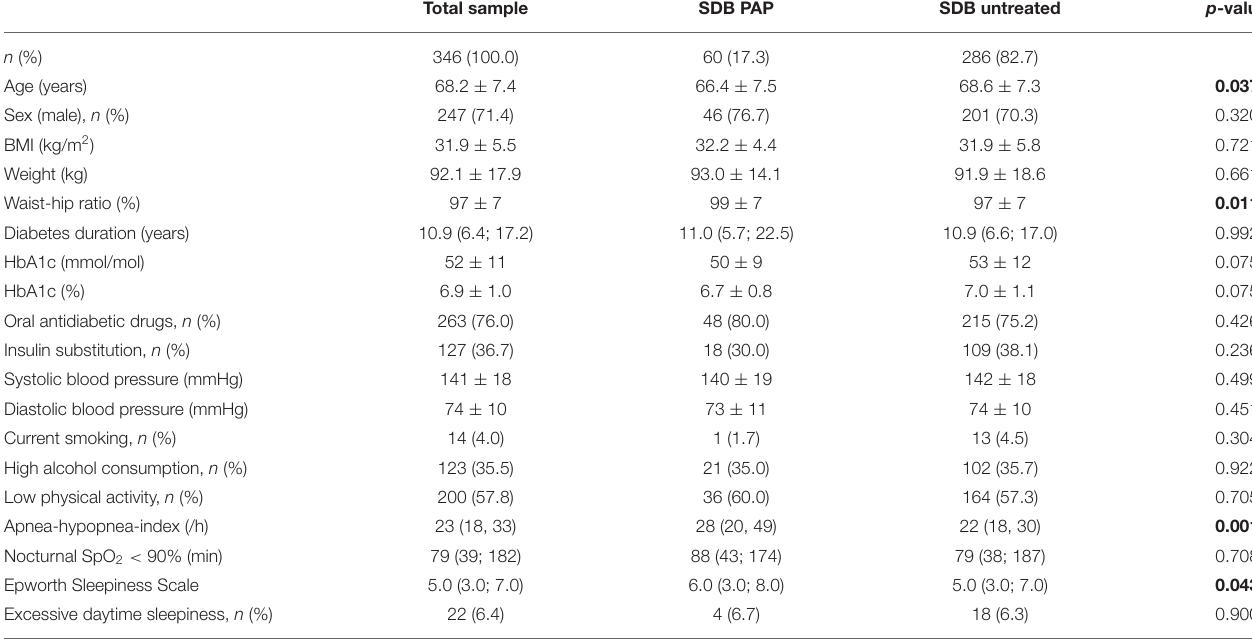
TABLE 1 | Clinical characteristics of the 346 analyzed subjects at the DIACORE baseline